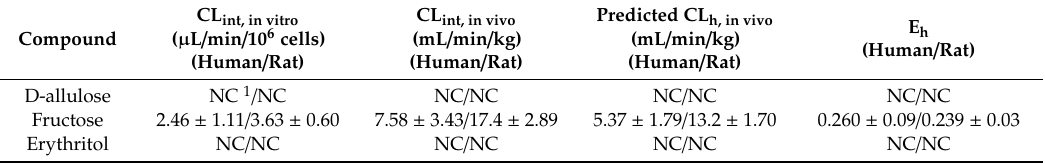
Table 4. In vitro and In vivo intrinsic clearance (CL int, in vitro and CL int, in vivo ), predicted